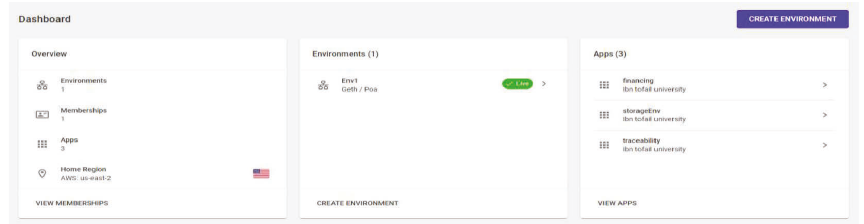
Figure 6: Characteristics of the testing environment.